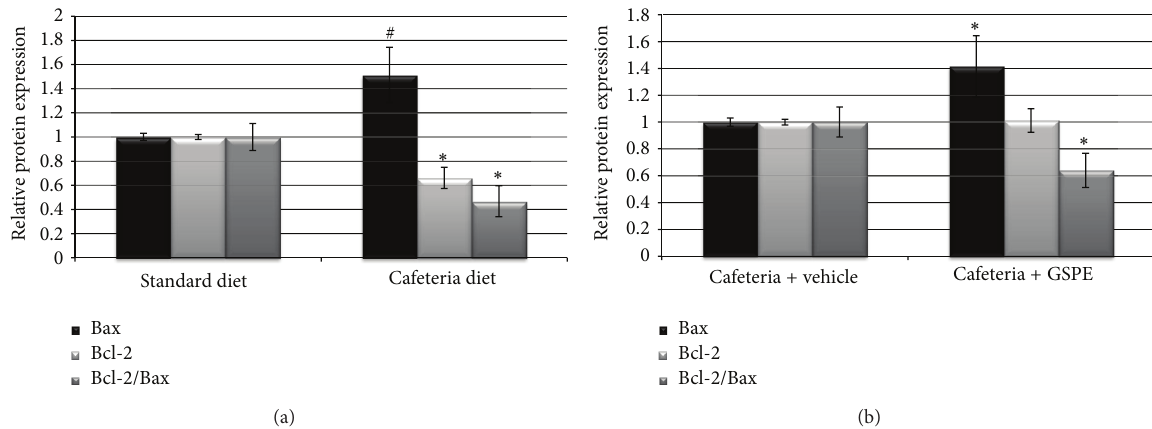
Figure 1: Protein expression of the apoptosis markers Bcl-2 and Bax and the calculated ratio of Bcl-2/Bax in: (a) standard-diet-fed rats and cafeteria-diet-fed rats and (b) in GSPE-treated rats and vehicle-treated rats assessed by Western Blot. Data are shown as the mean ± SEM. ∗ 𝑃 ≤ 0.05 and # 𝑃 ≤ 0.1 .